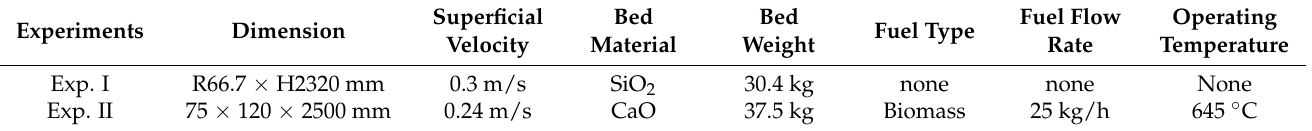
Table 4. Experimental